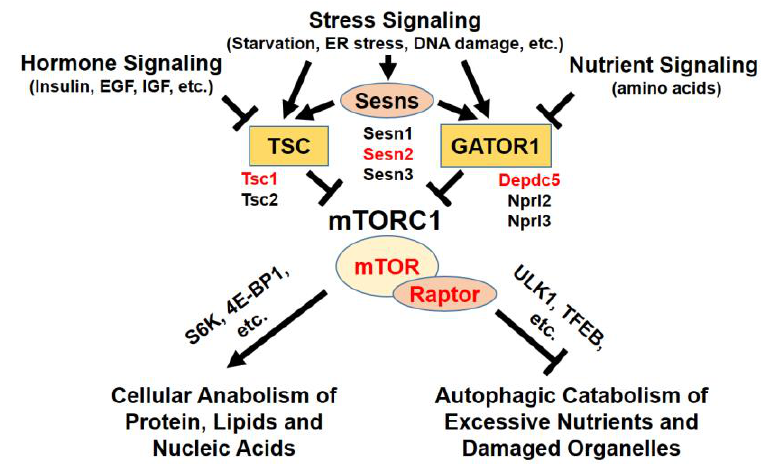
Figure 1. Upstream and downstream of mTORC1 signaling. mTORC1 is regulated by hormone, growth factor, stress, and nutrient signaling. Through signaling mediators, such as Sestrins, TSC, and GATOR1 protein complexes, mTORC1 activity is delicately modulated in cells. Active mTORC1 kinase phosphorylates various substrates to regulate cell metabolism. Red-highlighted genes were mutated in livers to understand the hepatocellular role of mTORC1.